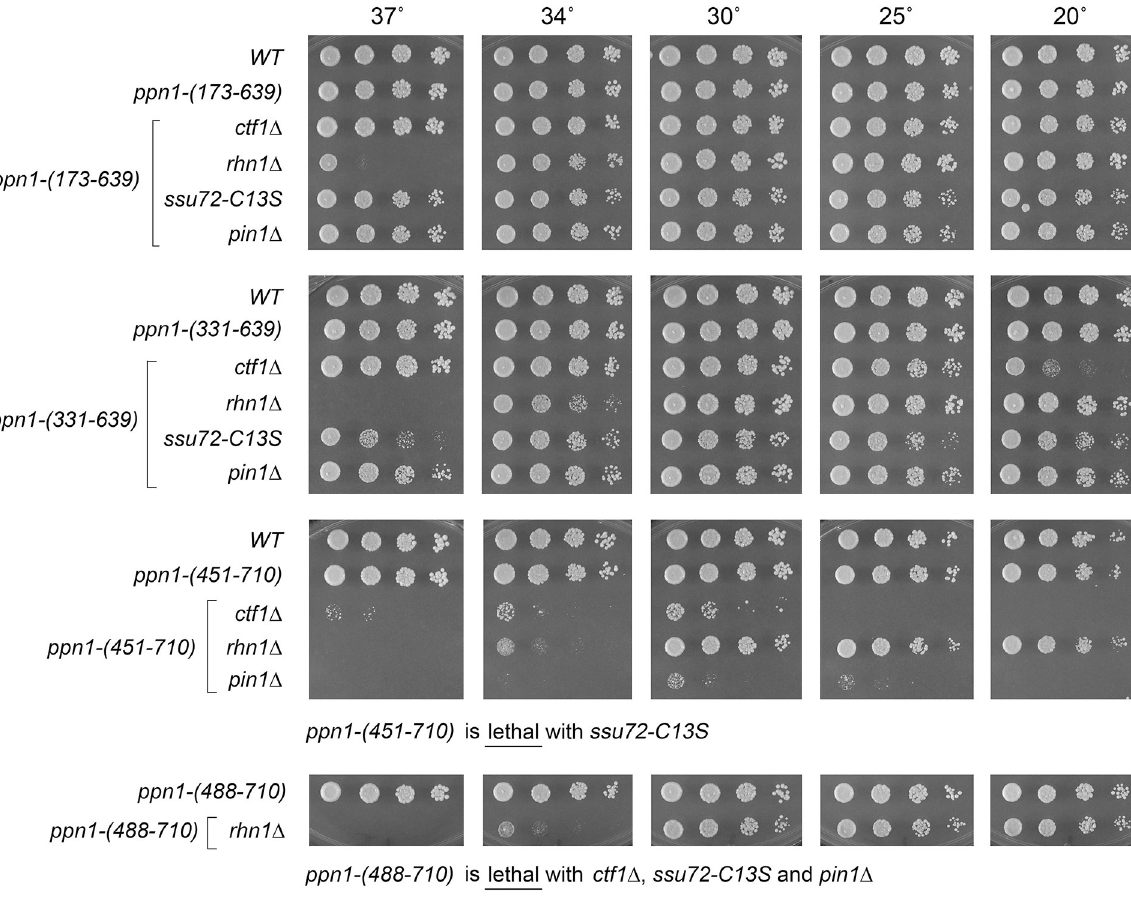
Fig 9. Activity of Ppn1 truncations in CPF/Rhn1/Pin1 mutant backgrounds. Strains with the indicated ppn1 truncation alleles in combination with CPF subunit, Rhn1, or Pin1 mutants as specified were spot-tested for growth on YES agar at the indicated temperatures. Synthetic lethalities of ppn1-(451–710) and ppn1-(488–710) are specified below the panels.